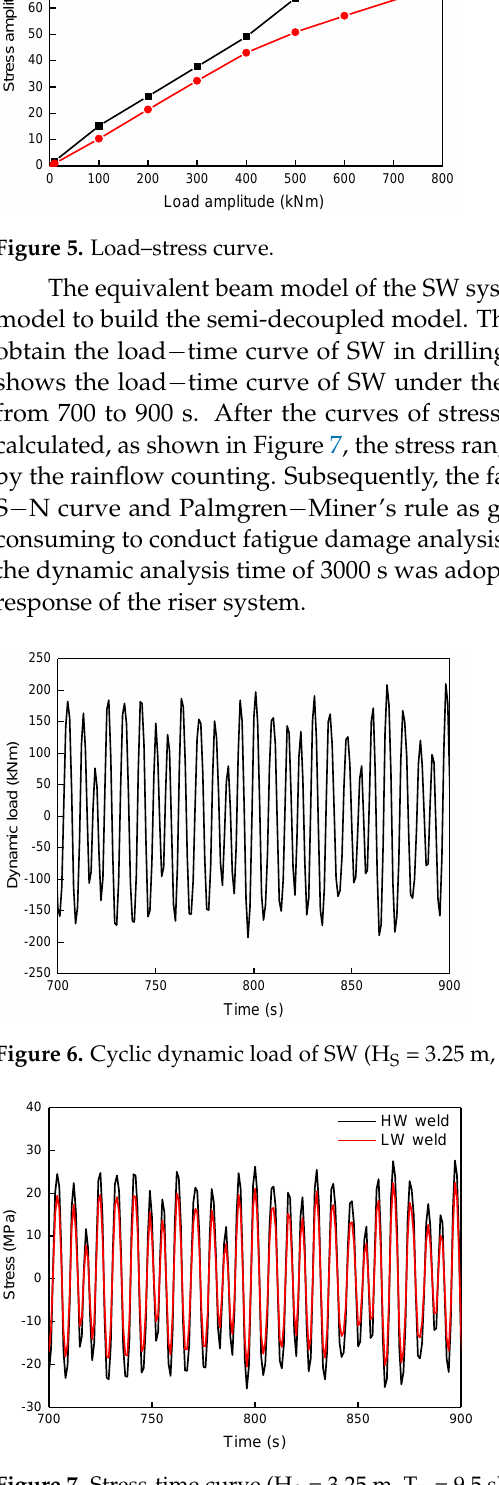
Figure 5. Load – stress curve.